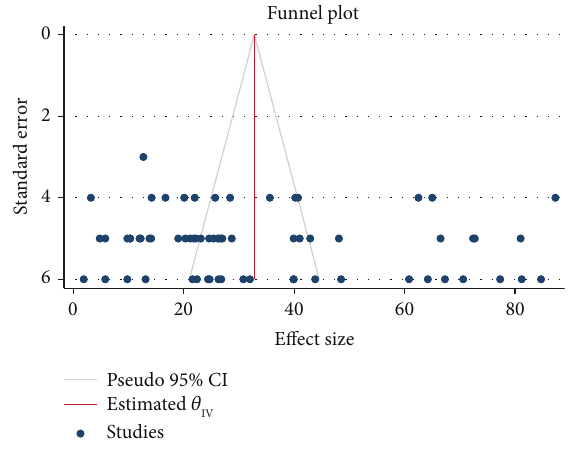
Figure 4: Funnel plot of the studies